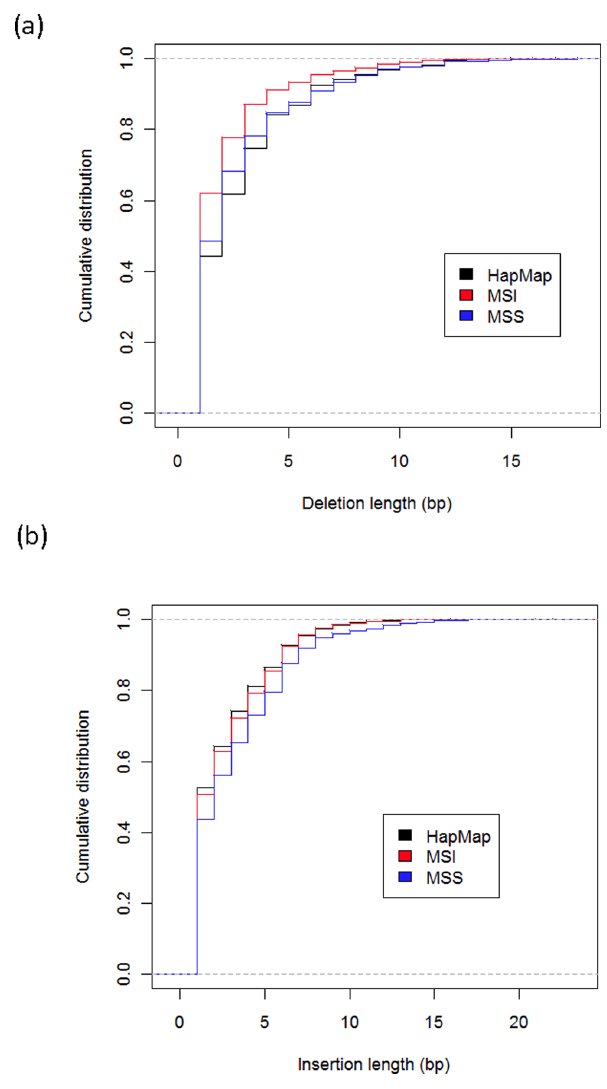
Figure 4. Cumulative distribution of microsatellite indel lengths for cancer cell lines and HapMap samples. (a) Microsatellite deletions (b) Microsatellite insertions.